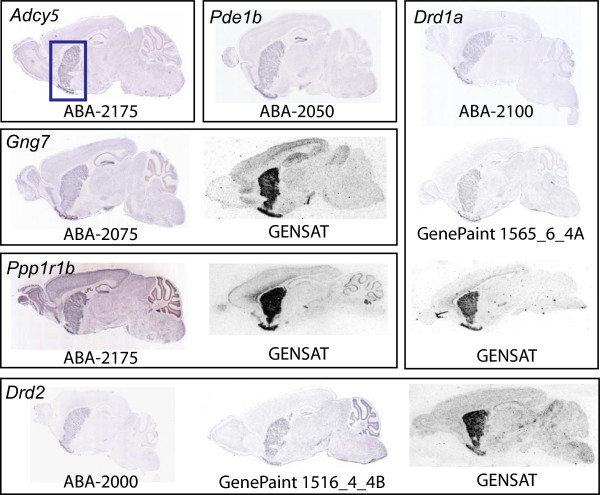
Genes involved in the neuronal cAMP signaling pathway share a similar striatum-enriched hybridization profile to Adcy5. Brain images were obtained from the ABA, GenePaint.org, and GENSAT databases. The striatum region is outlined in ABA-2175.